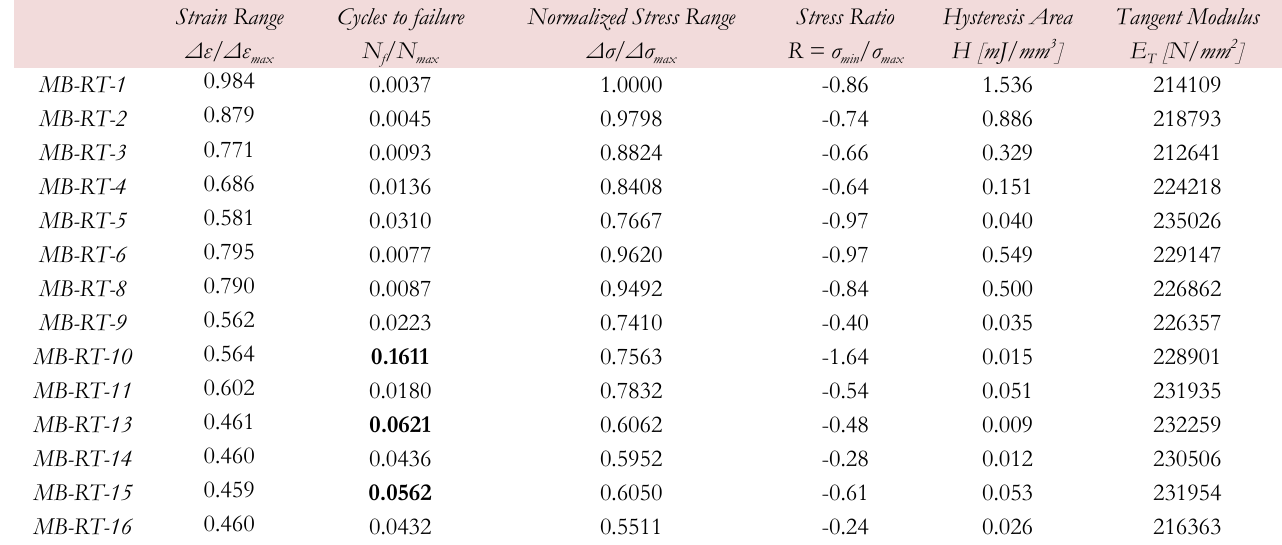
Table 2: Base Material – Room Temperature: fatigue test results.